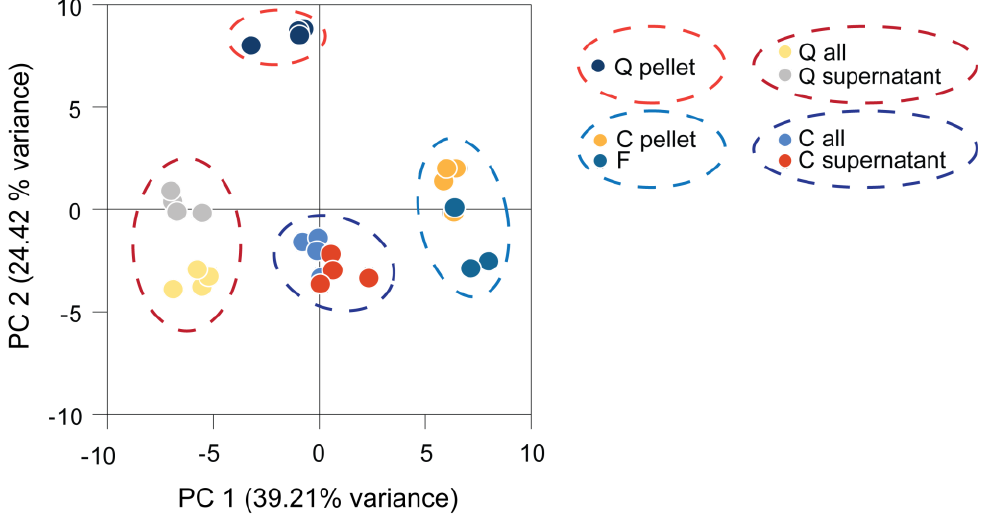
Figure 2. Principal component (PC) analysis of Chlamydomonas metabolite profiles obtained by different harvesting methods. Four replicates were harvested and processed from the same culture by each harvesting method and measured by GC-MS. The generated metabolite profiles were normalized to the internal standard and log being subjected to principal component analysis. C, centrifuged; F, filtered; Q, quenched; all, cells and